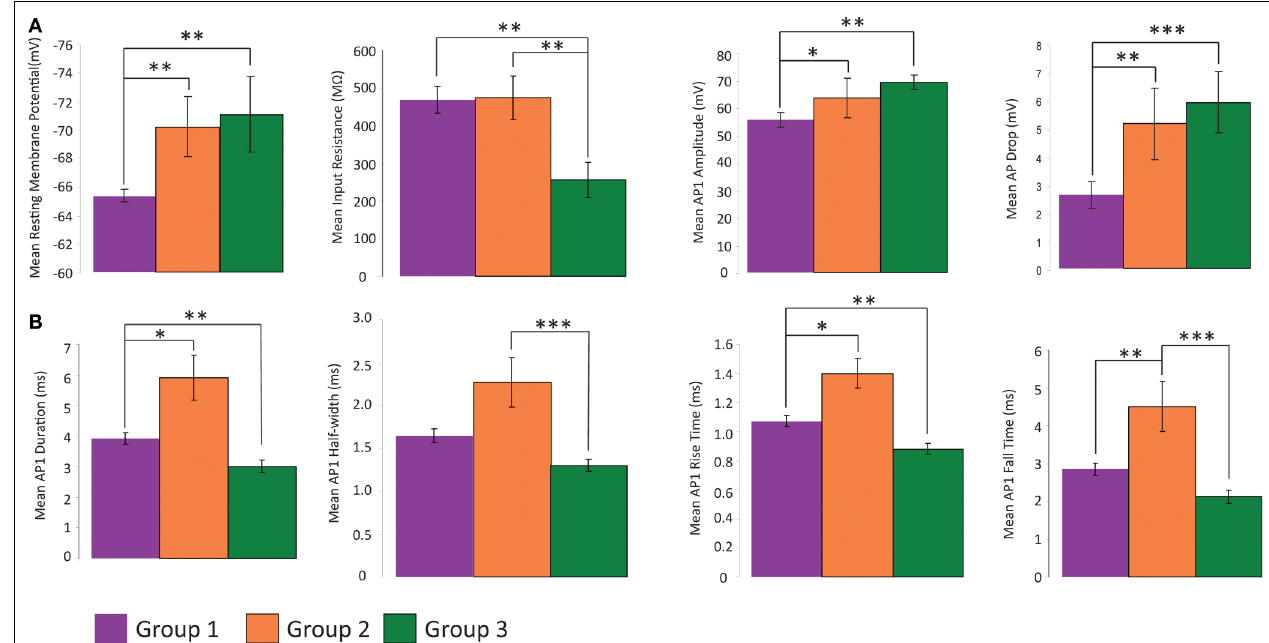
amplitude and difference in amplitude between fi rst and second AP of a train. (B) Each group has a distinct time course of AP, with group 1 intermediate between groups 2 and 3. (* p ≤ 0.05, ** p ≤ 0.025, *** p ≤ 0.005, Mann Whitney U